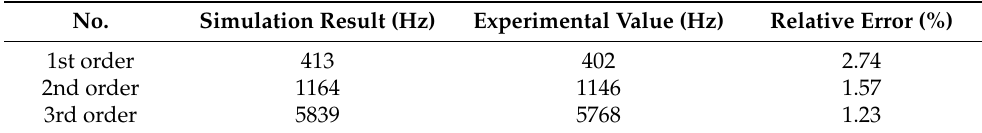
Figure 5. The test rotor for the modal test. ( a ) Rotor model. ( b ) Rotor test bench. Table 1. The first three natural